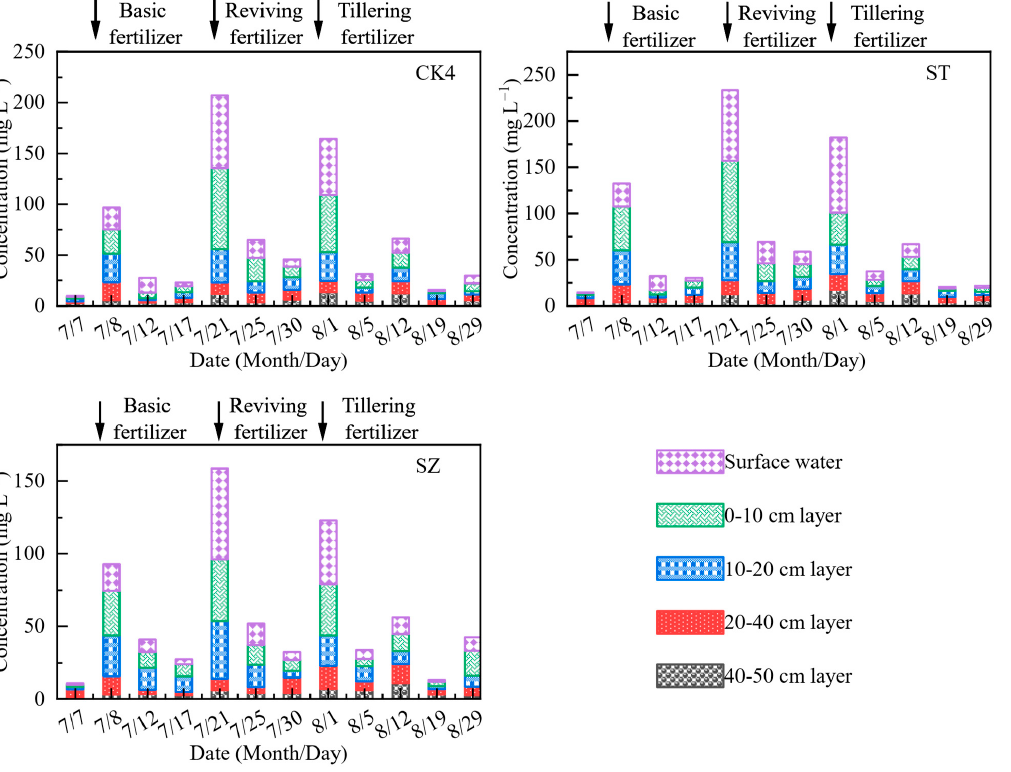
the peak values of the three groups (ST (233.47 mg L − 1 ) > CK4 (206.96 mg L − 1 ) > SZ (158.63 mg L − 1 )), the addition of zeolite had an effect on the peak value of TN, and its ad-